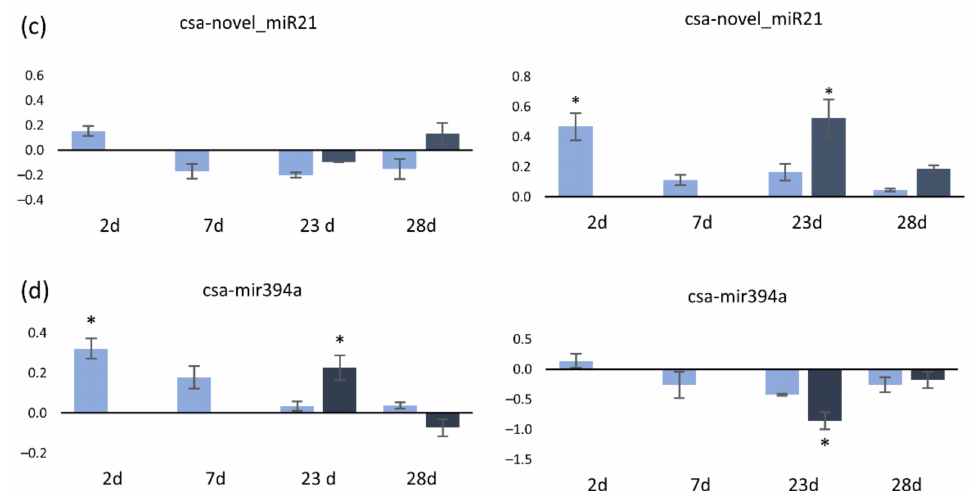
Figure 11. Expression level of three novel miRNAs, i.e., csa-novel_miR1 ( a ), csa-novel_miR20 ( b ), csa-novel_miR21 ( c ) and one known csa-miR394a ( d ) determined in non-primed and primed plants of WL-T and WL-S cucumber accessions. 1xH—non-primed plants, Rec—non-primed plants after 14-day recovery period, 2xH—primed plants. Data are the mean of three independent replicates. Asterisks indicate a significant difference vs. control plants determined with Student t-test, p < 0.05.